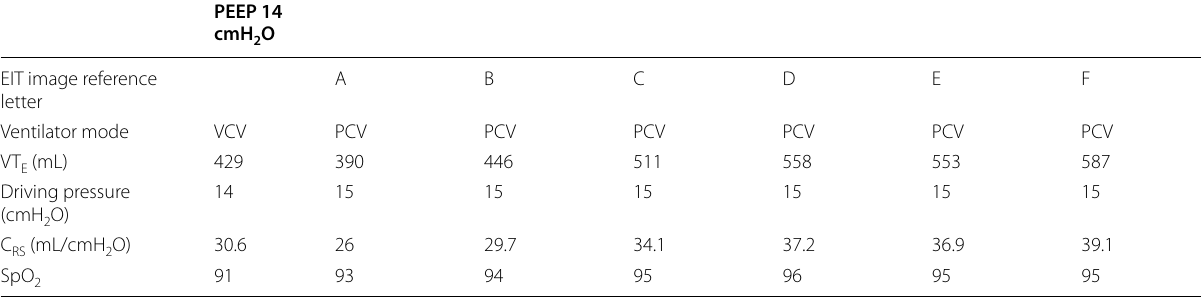
Table 1 Respiratory mechanics and oxygen saturation recorded during each step